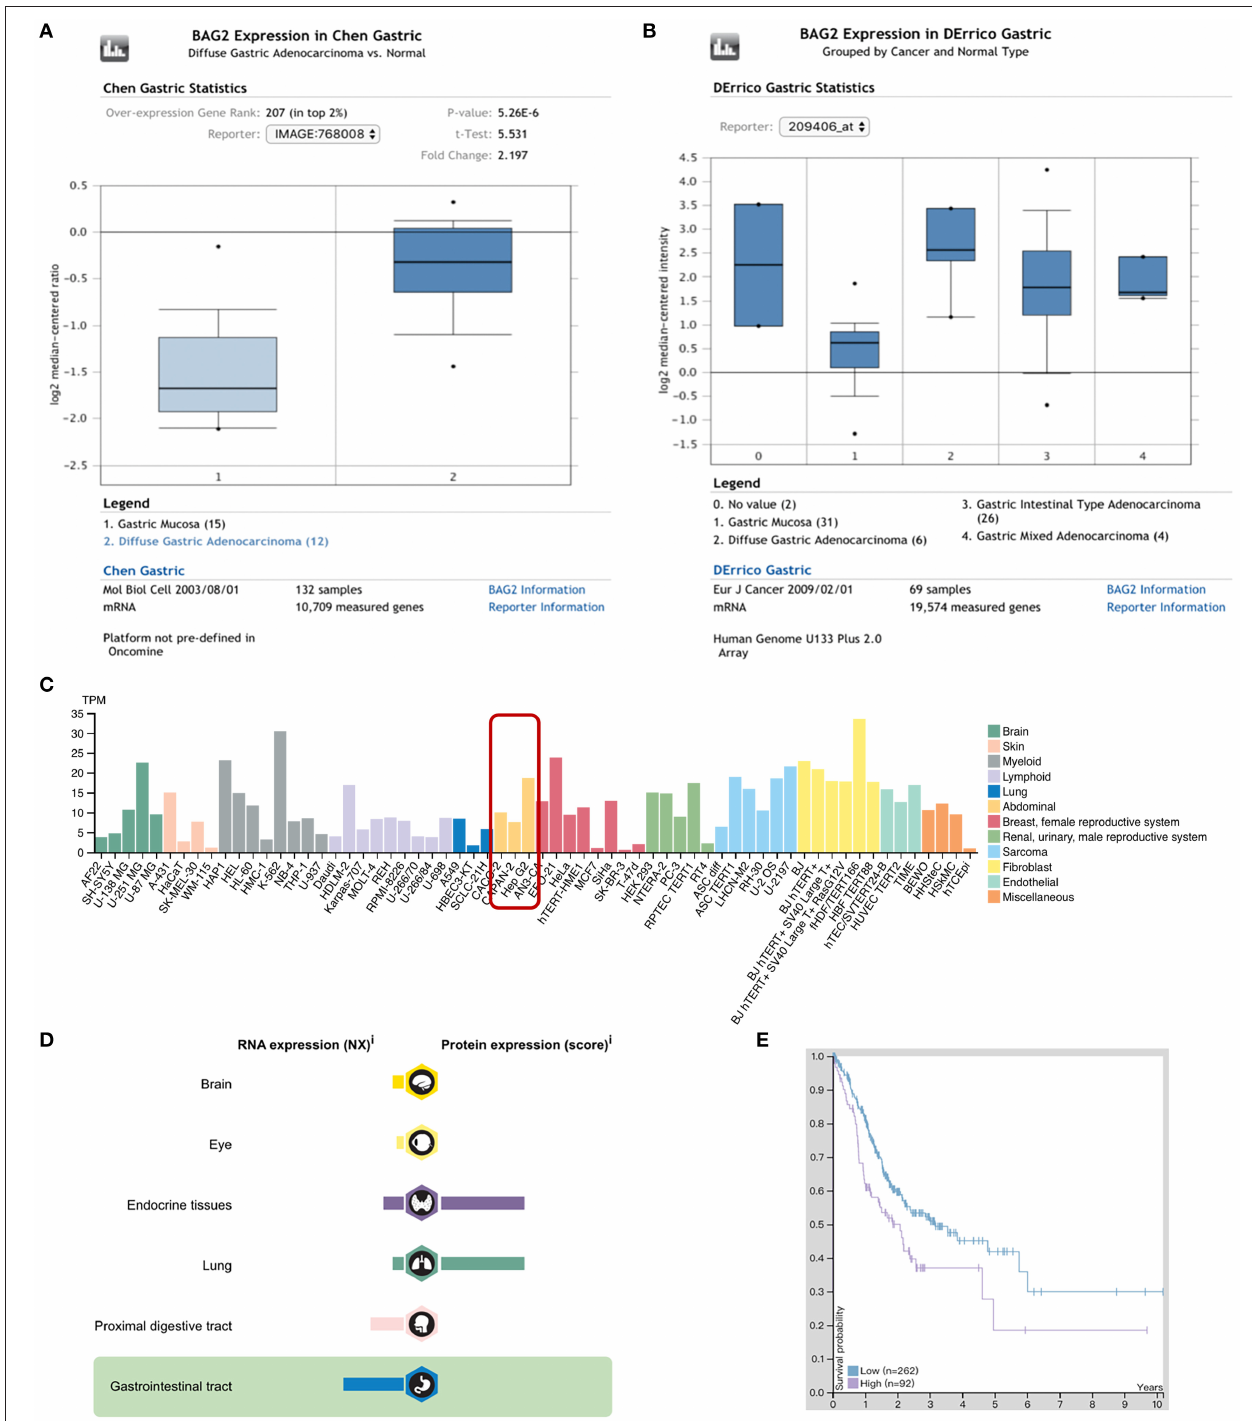
FIGURE 1 | Expression of BAG2 in gastric carcinoma in Oncomine and Human ProteinAtlas databases. (A) Expression of BAG2 in gastric carcinoma is higher than normal gastric mucosa (Oncomine); (B) Expression of BAG2 in different types of gastric carcinoma (Oncomine); (C) BAG2 is highly expressed in various abnormal tumor cell lines (Human Protein Atlas); (D) Distribution and proportion of BAG2 mRNA and protein expression in various tissues of human body, including gastrointestinal tract (Human Protein Atlas); (E) Prognostic analysis of BAG2 in gastric cancer showed that the high expression of BAG2 suggested a poor prognosis (The purple line represents high expression of BAG2 , and the blue line represents low expression of BAG2 . When the FPKM cutoff value of BAG2 is 4.6, the survival time has significant statistical significance (Human Protein Atlas).